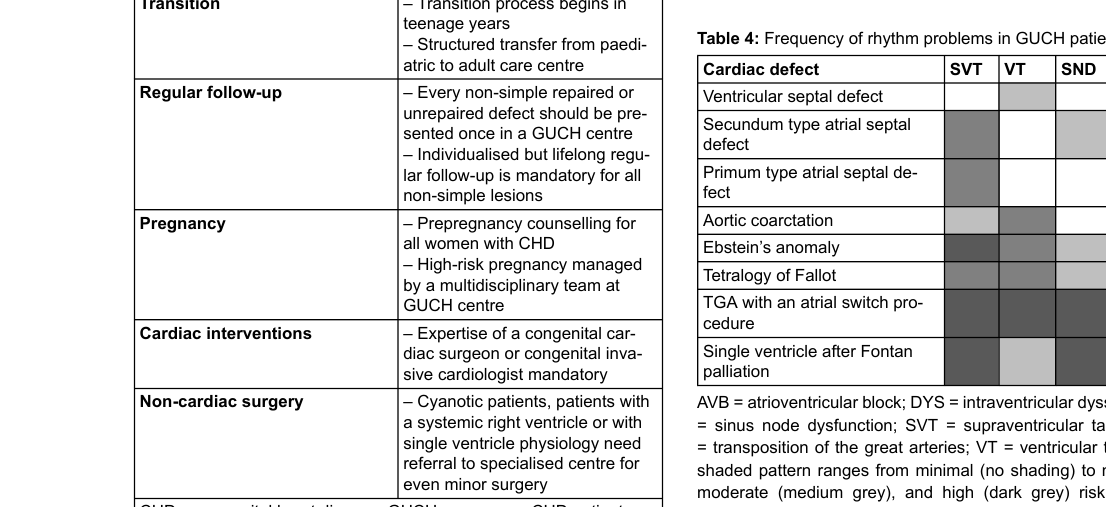
Table 2: Minimal standards of care for adolescents and adults with congenital heart disease. Transition